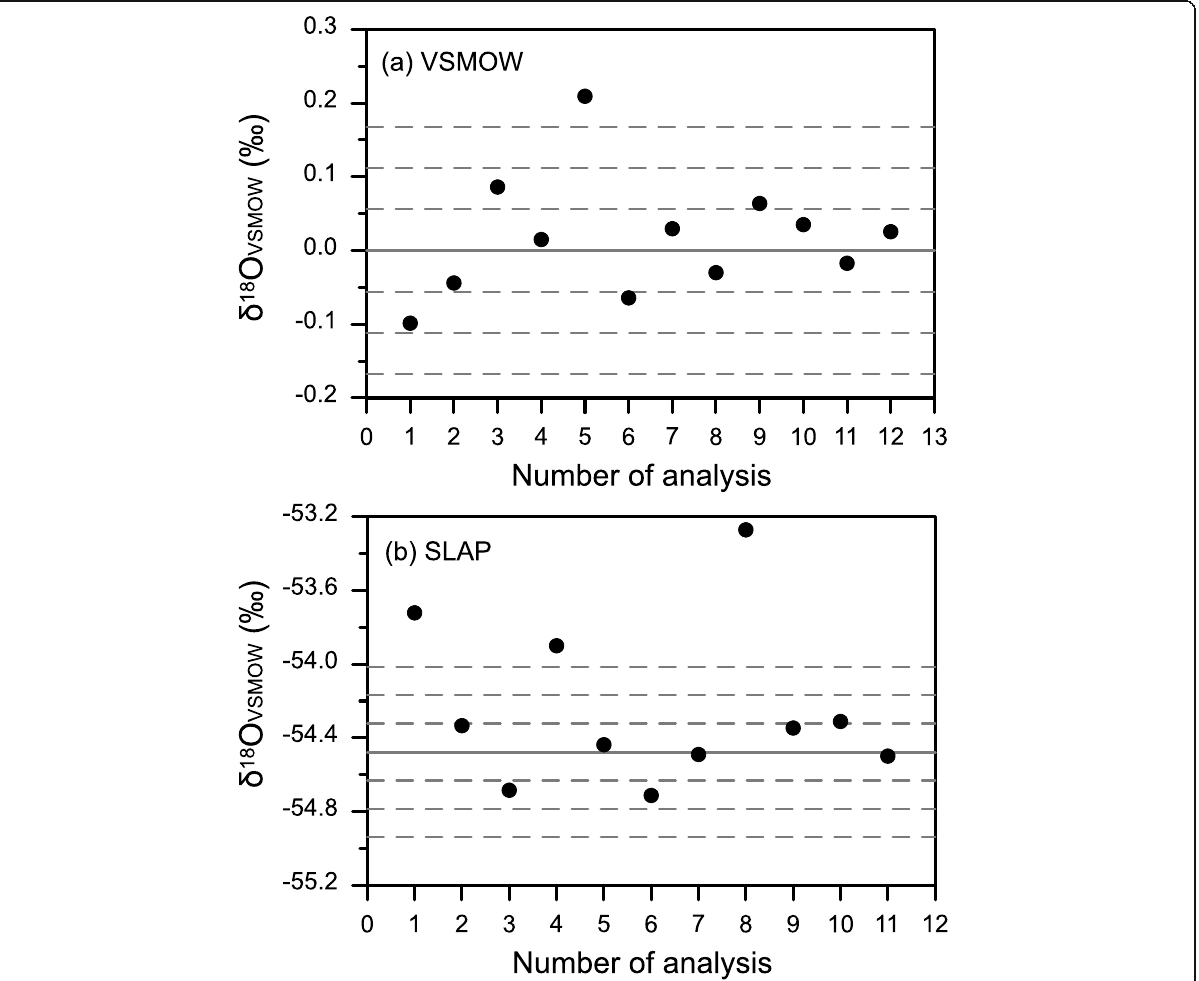
Fig. 2 Oxygen isotope compositions of a VSMOW and b SLAP. 3 σ outliers are not included in the calculations of average and standard deviation. Solid gray lines indicate average values. Dashed gray lines display 1 σ , 2 σ , and 3 σ standard deviations,